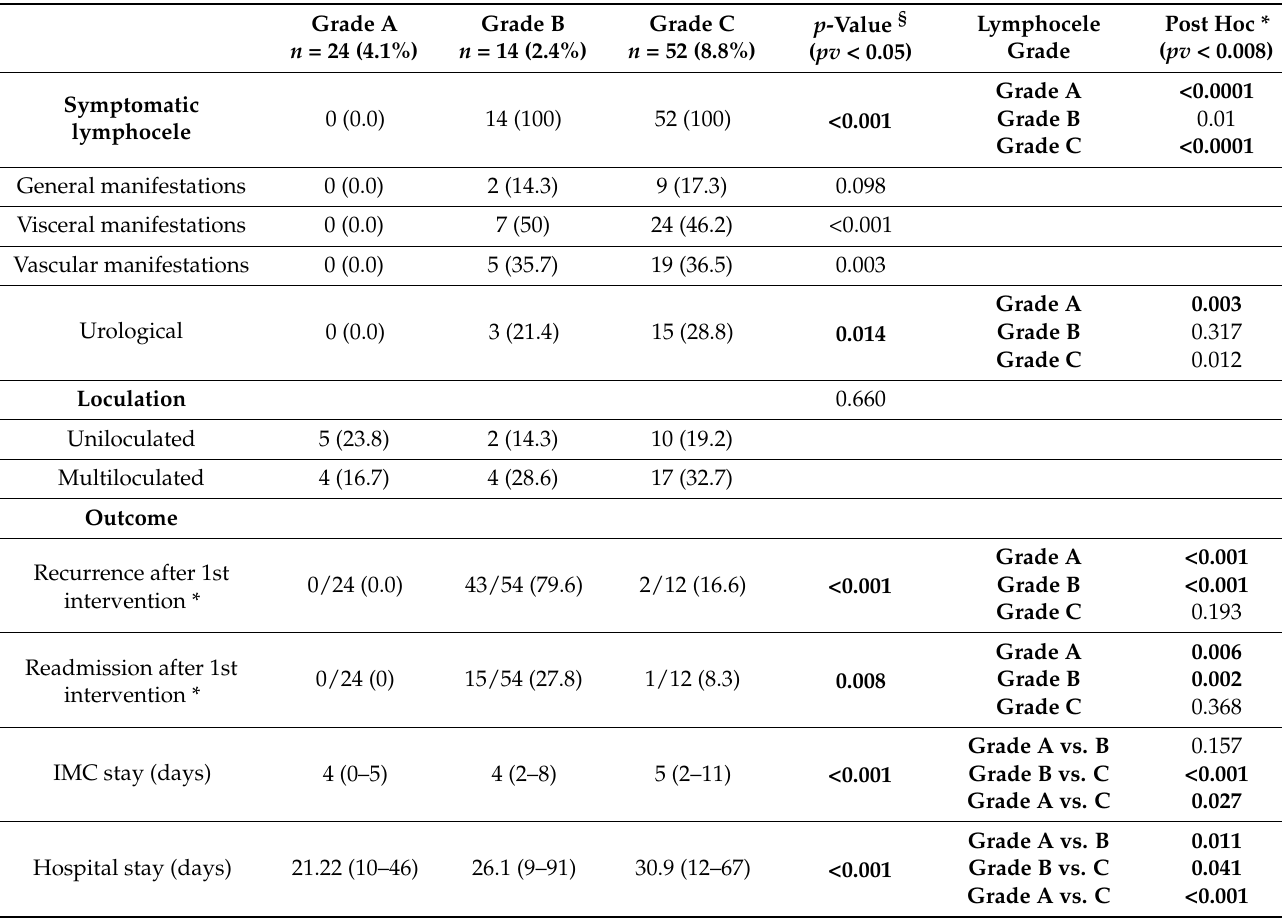
Table 3. Different manifestations of lymphocele formation following kidney transplantation with related postinterventional results, divided and compared based on the grade of lymphocele following kidney